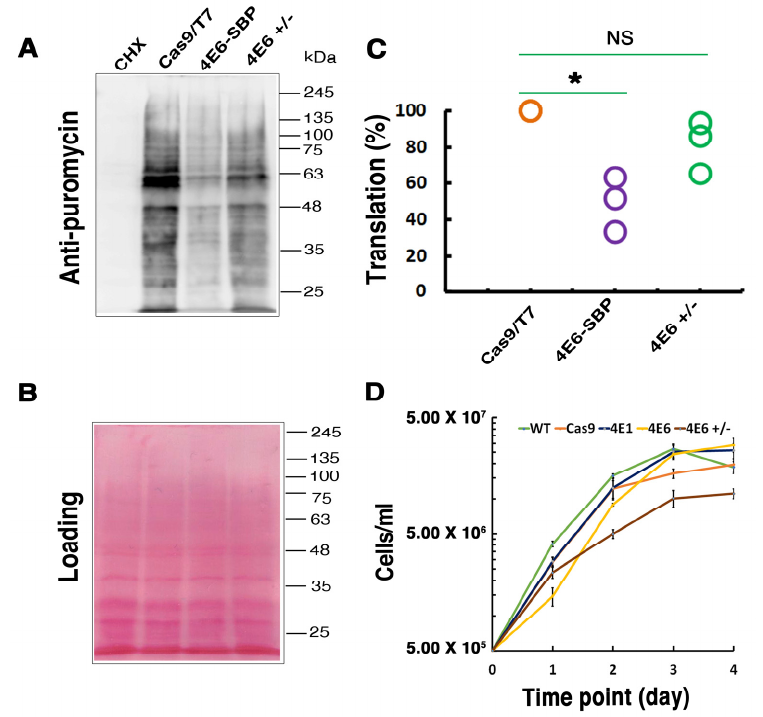
Figure 8. Global translation in the hemizygous mutant LeishIF4E-6(+/ − ). The SBP-tagged LeishIF4E- 6 and the LeishIF4E-6(+/ − ) mutants along with Cas9/T7 overexpressing cells were used for the SUnSET assay. Cycloheximide treated wild type cells served as a negative control for translation. ( A ) All cells were then incubated with 1 µg/mL puromycin for 20 min, extracted, separated over 12% SDS-PAGE and subjected to western analysis using specific antibodies against puromycin. A cycloheximide (CHX) control for complete translation inhibition is also shown. ( B ) Similar protein loads were validated by Ponceau staining of the blots; ( C ) densitometry data to quantify the puromycin incorporation in the different cell lines, as compared to puromycin incorporation in Cas9/T7 overexpressing control cells (100%). GraphPad Prism was used for statistical analysis. Three independent experiments were performed, and the individual values are presented as dots. Statistical significance was determined using the Kruskal–Wallis test with Dunn’s multiple-comparison test for comparing three or more groups. Significant p -values were marked as follows: p -value < 0.05 (*). NS is non-significant. ( D ) Growth curves of the different cell lines were generated by monitoring the cell counts during five consecutive days. Wild-type cells are shown in green, cells overexpressing the Cas9/T7 are in orange, cells overexpressing LeishIF4E-1 are in blue, cells overexpressing LeishIF4E-6 are shown in yellow, and the hemizygous mutant LeishIF4E-6(+/ − ) cells are shown in